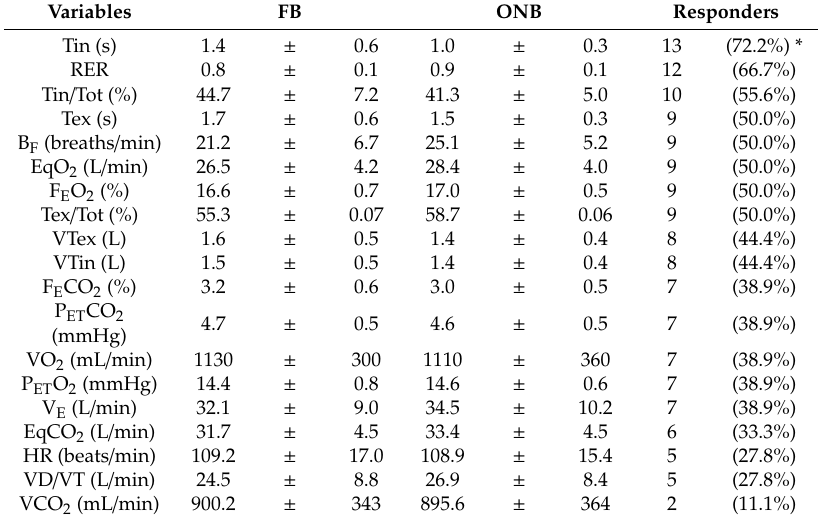
Table 2. Descriptive values and number of responders and non-responders by cardioventilatory variables. Variables